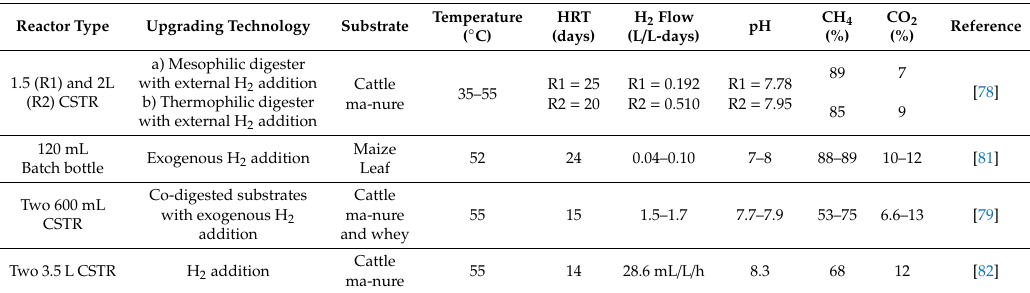
Table 3. In-situ enriched H 2 upgrading